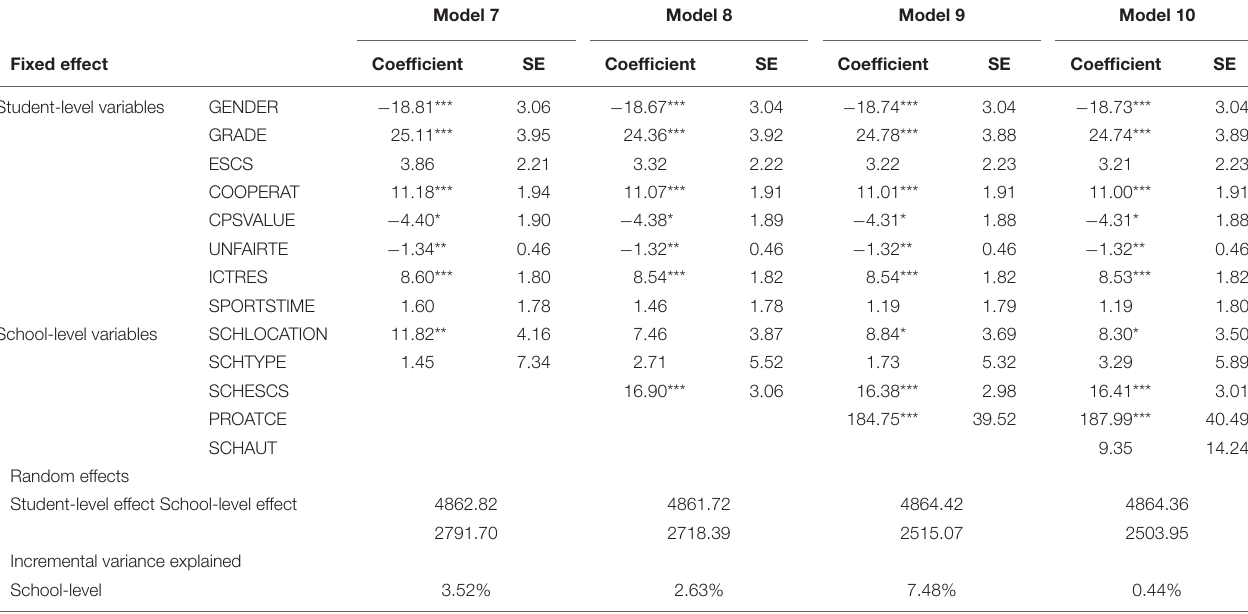
TABLE 6 | The Analysis Result of the School-level Model (Model 7–Model